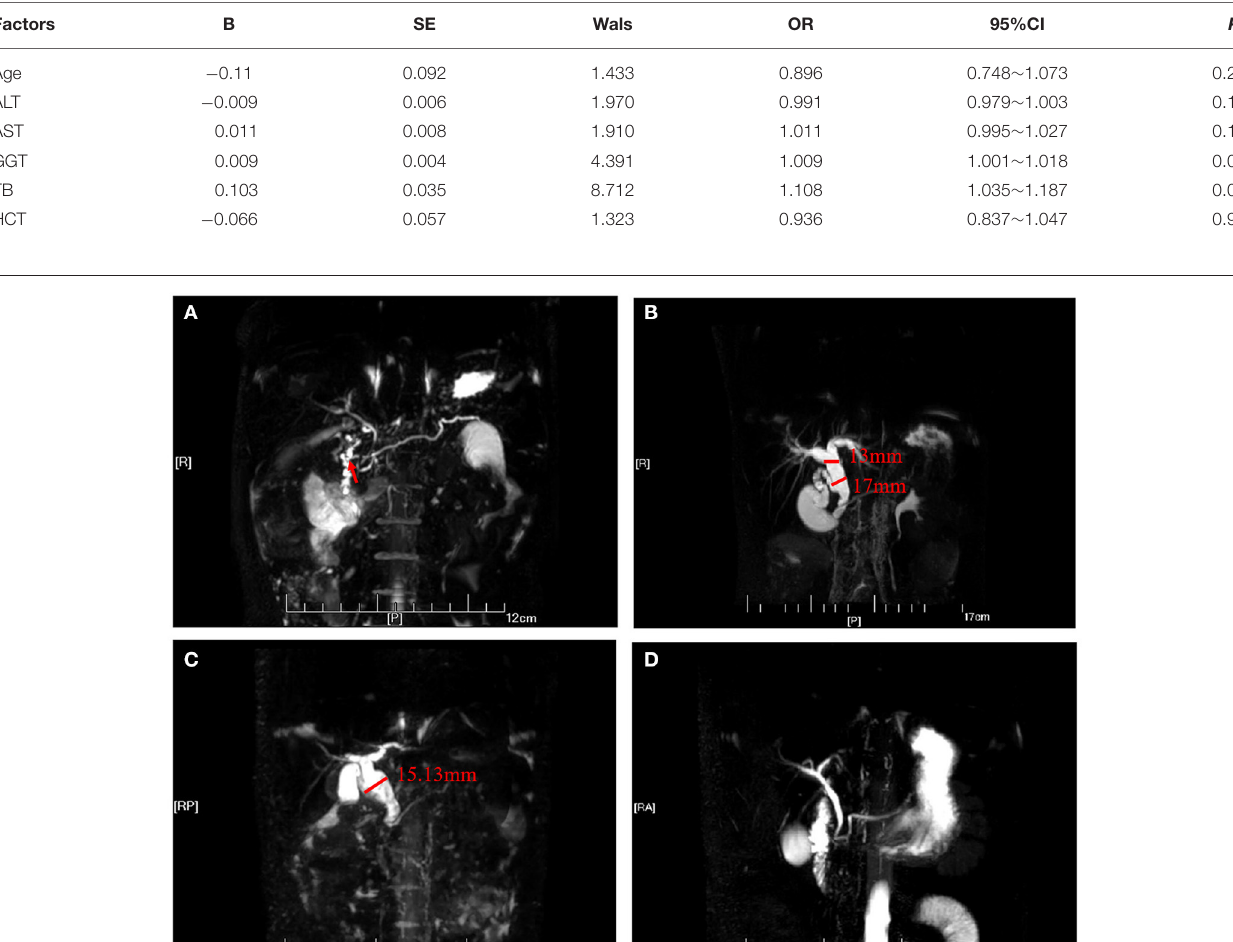
(3.85 ± 3.34) years old than for those in the non-PMP group (6.68 ± 3.62 years old, P < 0.05). The interval of recurrence was 7.7 ± 8.52 months for the PMP group, which was shorter than that of the non-PMP group (15.44 ± 16.98 months, P <